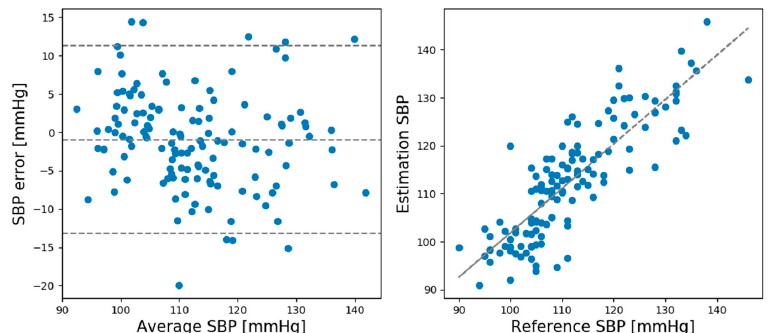
Figure 5. Bland–Altman plots for systolic blood pressure (SBP) estimation result of the CNN model in the rest session.